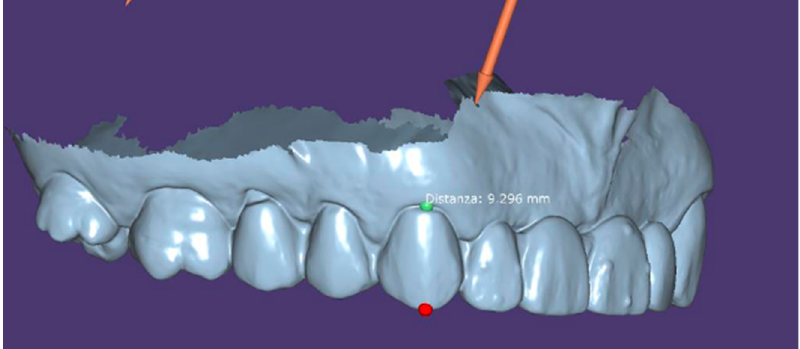
Figure 1. Intraoral Scan is an example of measurement (CCBY